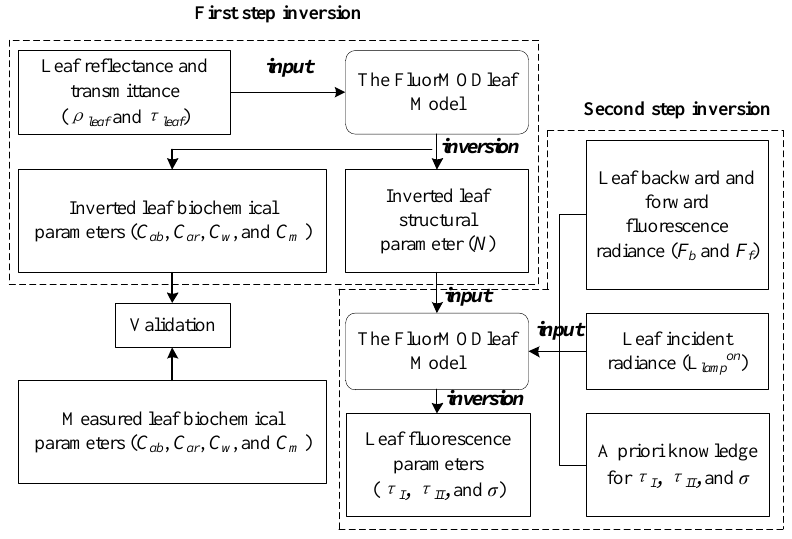
Figure 3. Flow diagram of the retrieval of the fluorescence parameters of plant